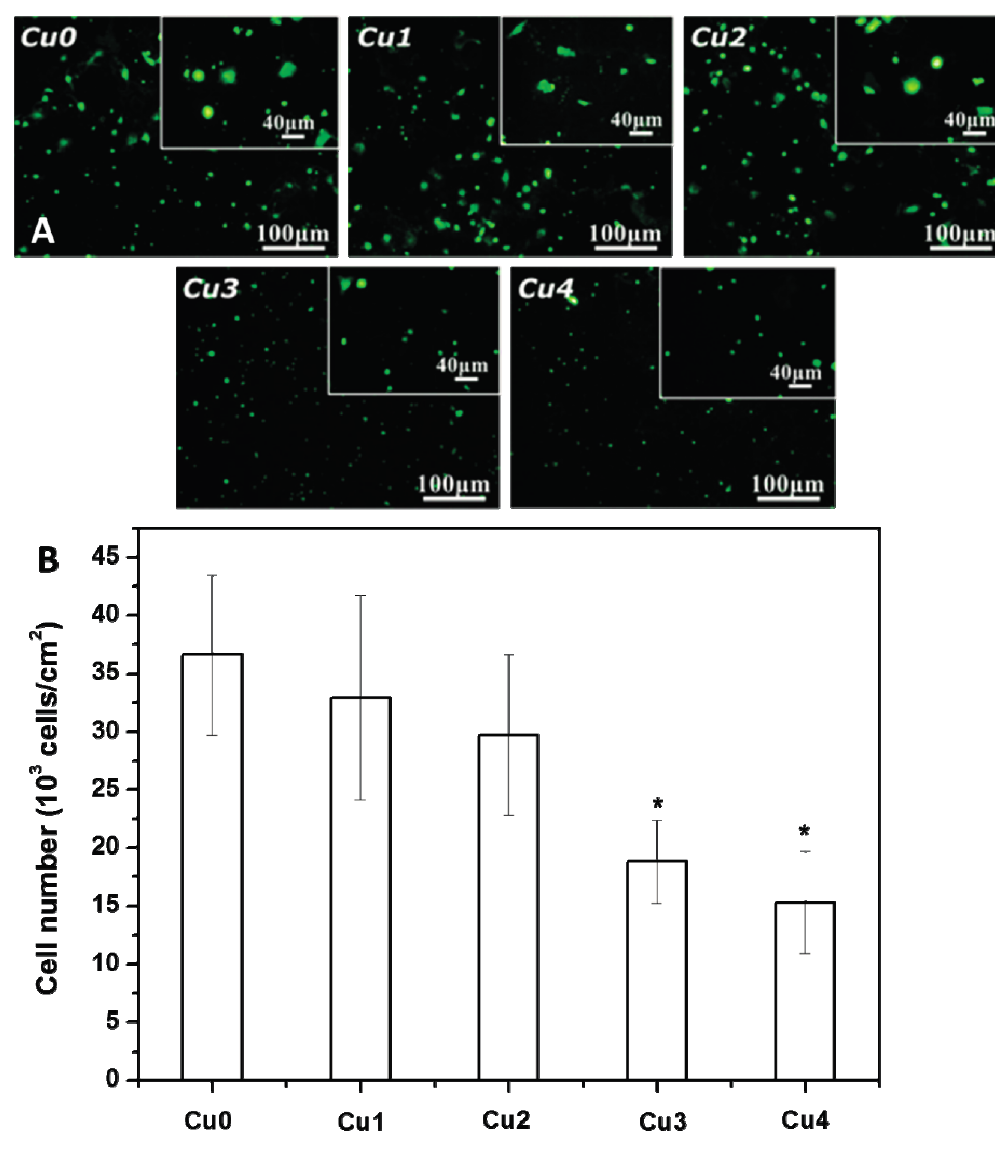
Figure 9. ( A ) The fluorescence photographs and ( B ) cell counting results of macrophages on the Cu0, Cu1, Cu2, Cu3 and Cu4 surfaces after 24 h incubation (mean ± SD, * p < 0.05 compared with Cu0, Cu1 and Cu2, n =